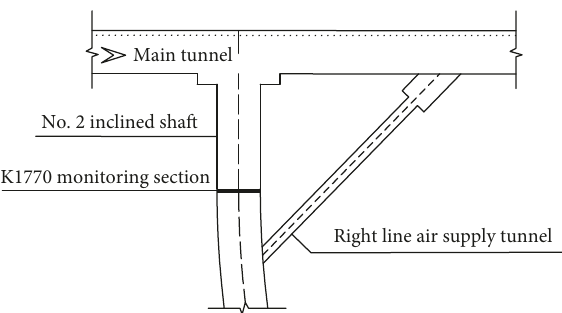
Figure 20: Monitoring section position.